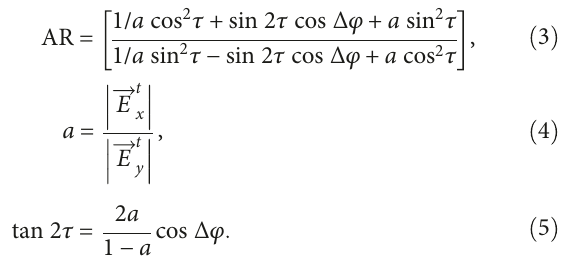
Figure 6: (a) Sample polarizer and test scenario. (b) Diagram of the setup.